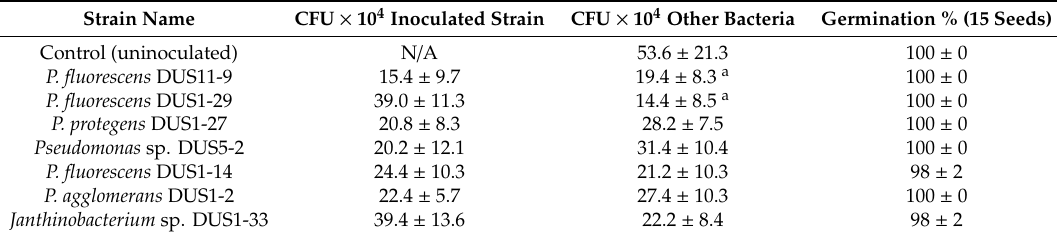
Table 4. Germination e ffi ciency, CFU of inoculated bacteria per g of sand-based medium and total bacterial CFU of other bacteria per g of soil-based medium associated with canola grown in sterilised soil-based medium for 91 days in a glasshouse system with media (soil) maintained at 8% water activity. For each strain, 1 × 10 3 CFU per 50 seeds of each strain were adhered to seeds using a xanthan gum and alginate based sticker 24 h prior to sowing. No significant di ff erence ( p < 0.05) was observed for CFU of inoculated strains in soil after 91 days. “a” denotes soil samples where the CFU of “other bacteria” in the growth medium is significantly lower ( p < 0.05) compared to the CFU of bacteria quantified from soil of the uninoculated control plants.